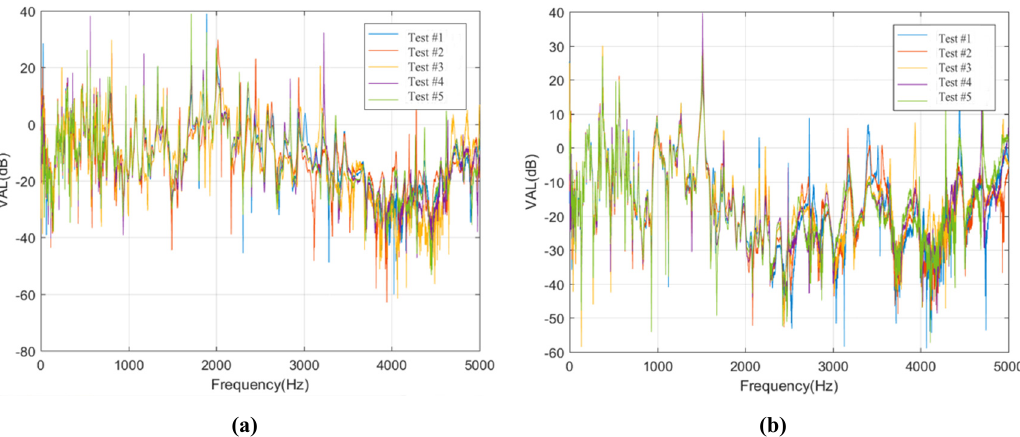
Figure 12. Acceleration level differences of the sensors on track slabs. ( a ) Acceleration level differences of sensor S1F2 in Condition #1; ( b ) Acceleration level differences of sensor S1J2 in Condition #2.